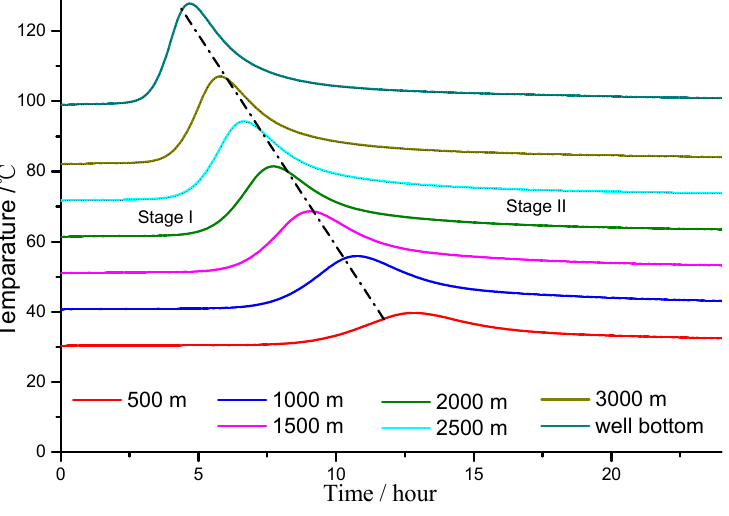
Figure 8. Temperature development in wellbore at different depths. As shown in Figure 9, the transient distribution of cement temperature in the well- bore is also calculated using the models established in this paper. In addition, the temper- ature increase at different depths is also calculated, as shown in Figure 10. The simulation results show that a temperature difference can be observed at the top of the cement due to the cement hydration heat. The obvious increase in temperature starts earlier for the cement in the deep part of the wellbore as a result of the faster hydration process. Simi- larly, the cement temperature shows a rapid increase, and then decreases to the environ- mental temperature.